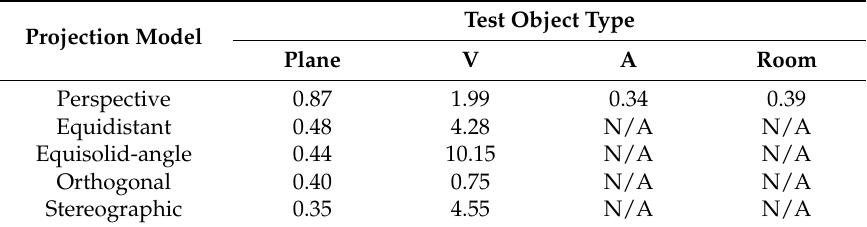
Table 14. RMS-residuals of IOPs (pixel).